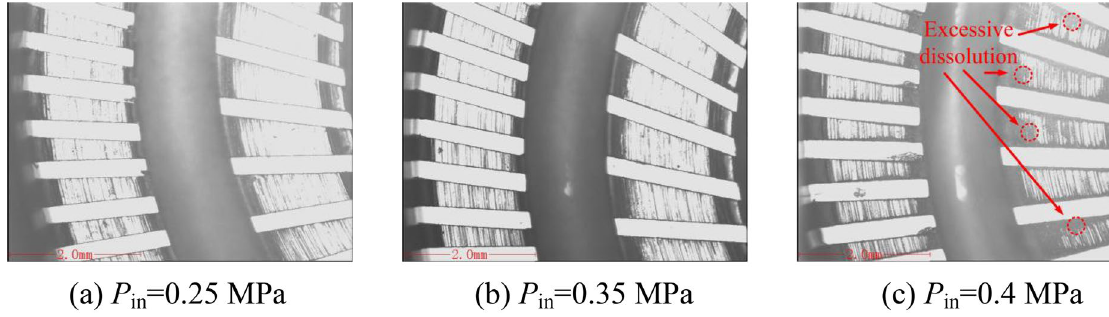
Figure 9. Torus surfaces processed by different inlet pressures.